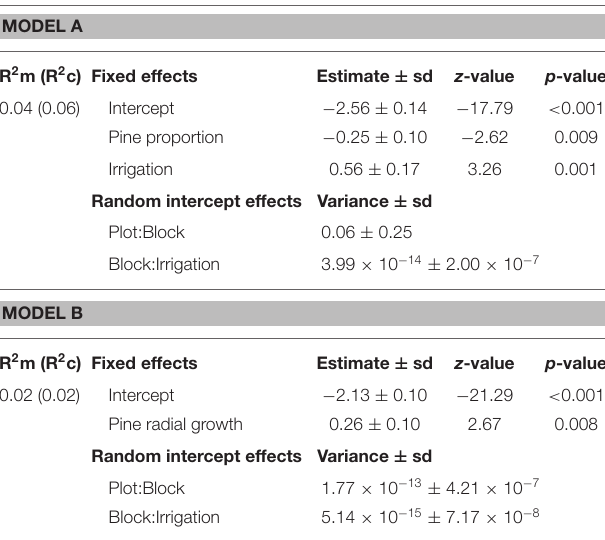
TABLE 4 | Summary of generalized linear mixed effects models (Binomial distribution) of individual pine attack probability before (Model a) and after